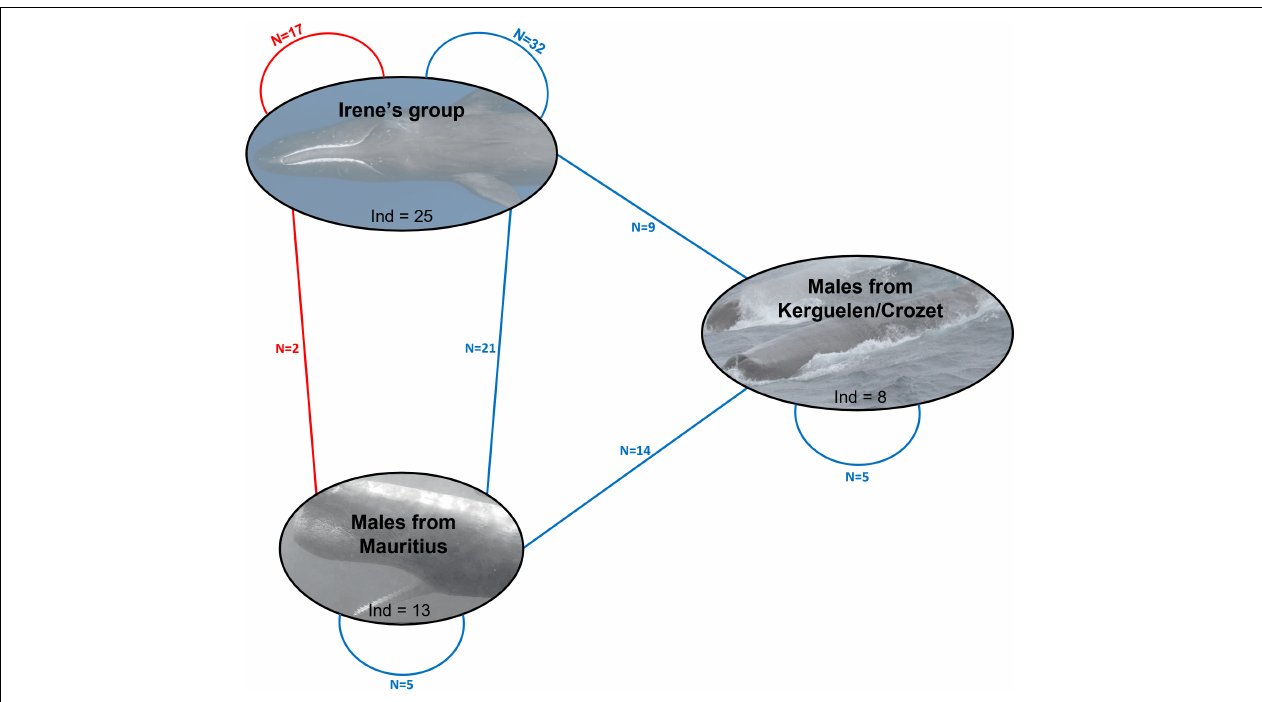
FIGURE 3 | Schematic representation of inferred first degree (in red) and second degree (in blue) kin relationships between the members of the Irène’s group and the adult male sperm whales sampled off Mauritius and in the Sub-Antarctic waters of the South of the Indian Ocean. The number of inferred first-degree (red lines) and second-degree (blue lines) relationships between sperm whales are represented between individuals of a same group (the Irène’s social group, the group of adult males sampled in Mauritius, and the one formed by adult males sampled in Crozet-Kerguelen) and between individuals of the same groups. Detail of these relationships is presented in the Supplementary Figure 2 . As stated in Sarano et al. (2021), this diagram was constructed to be consistent with the analyses conducted. Although we performed different analyses that produced similar results, uncertainty exists in the relatedness estimate calculations, which might influence some of these inferred